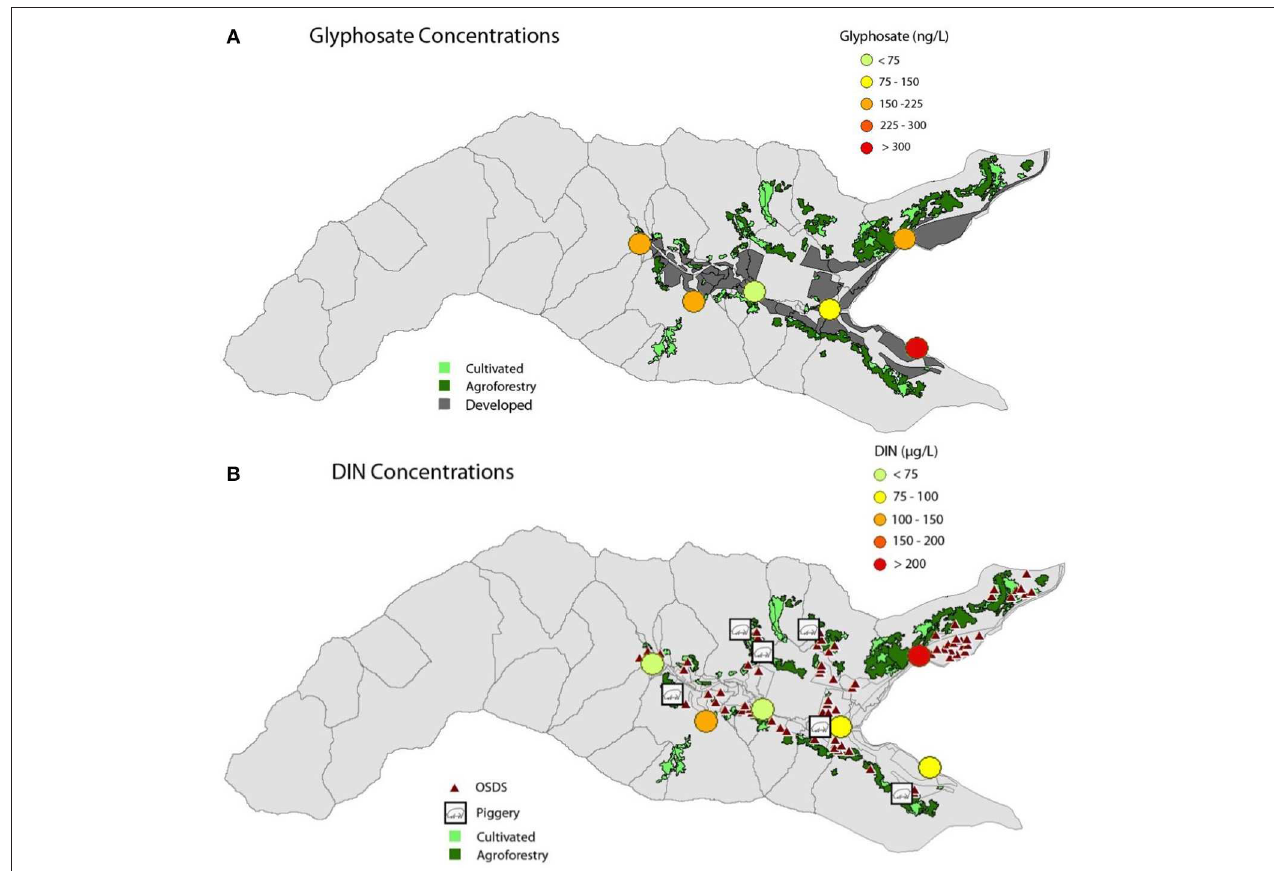
FIGURE 2 | (A) GLY and (B) DIN concentrations at the six groundwater sampling sites in Faga’alu, shown with related point source and land-use contributors—cultivated (light green polygons), agroforestry (dark green polygons), OSDS units (triangles), piggeries (square icons), and unpaved developed/residential land (dark